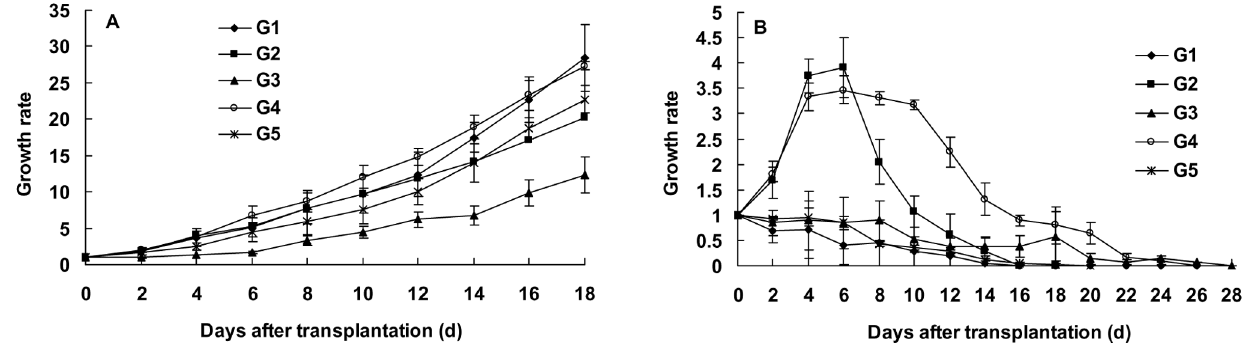
Figure 7. Growth rates of the cotton-specialized aphids on cotton (A) and on cucumber (B). The transferred aphids were reared for 1–5 generations (G1–G5) on cowpea. Bars are means 6 1SE.